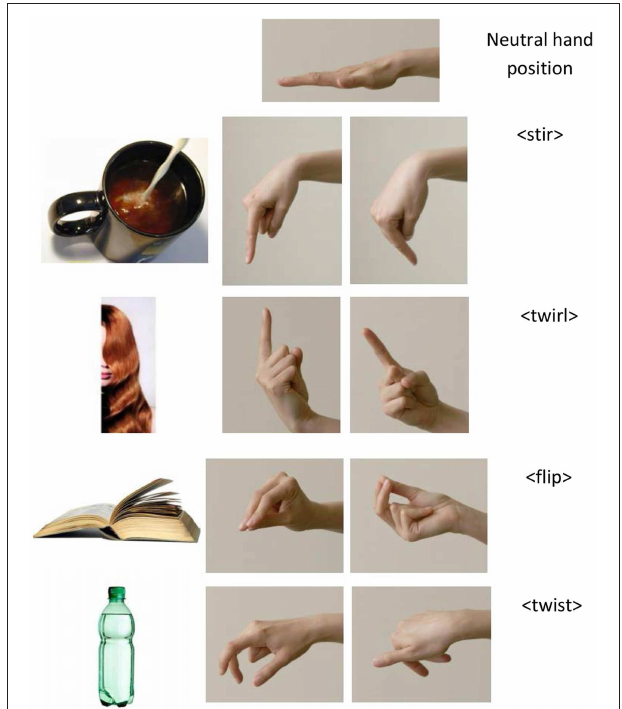
FIGURE 1 | The experimental materials (pictures) and the target gestures. The neutral hand gesture is the starting point in all conditions. The gesture immediately adjacent to the pictures of the stimuli portrays the first complete critical hand form that is used for RT coding (before the motion starts). The next picture shows how the motion